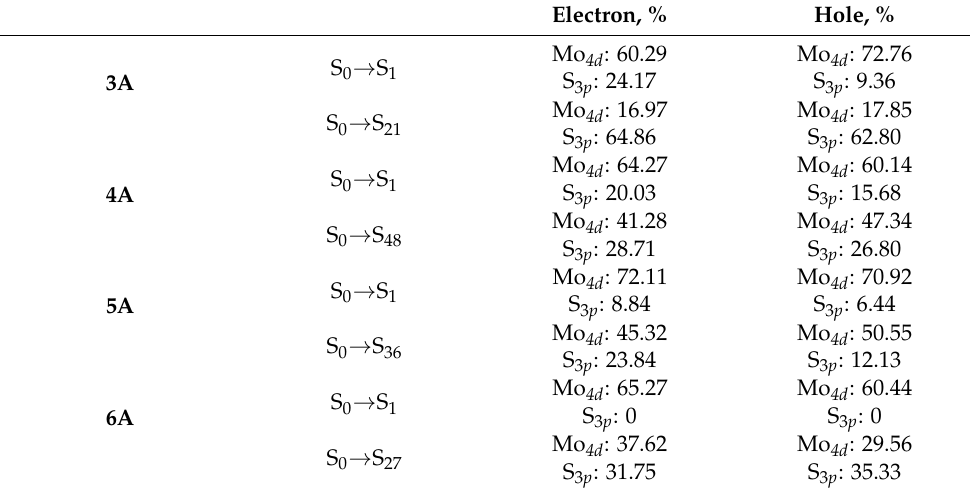
Table 4. Transition between the ground state and the lowest excited state S 0 → S 1 , transition between the ground state and the state with the largest oscillator strength S 0 → S n (normally associate with the intense absorption in the electronic absorption spectrum, n is usually different in different clusters), and the percentage of Mo 4 d and S 3 p in electron and hole of 3A , 4A , 5A , and 6A .